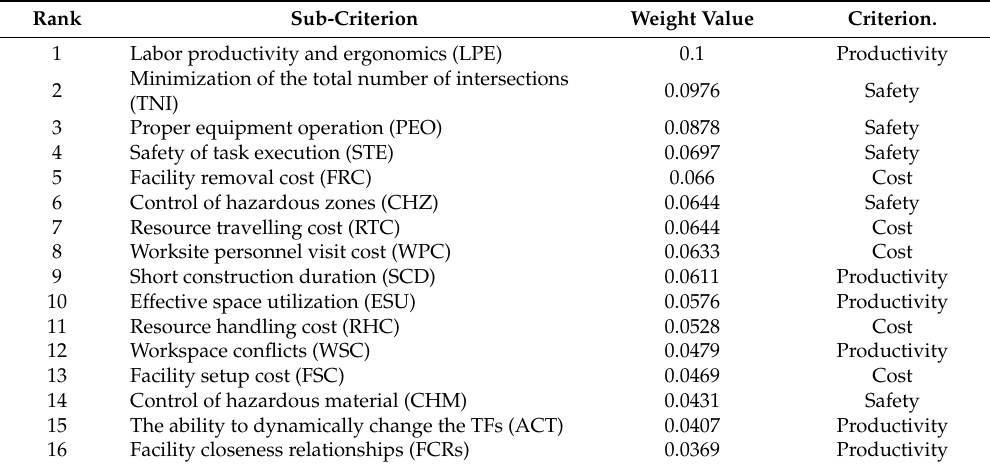
Table 10. Rank of sub-criteria for temporary facility layout